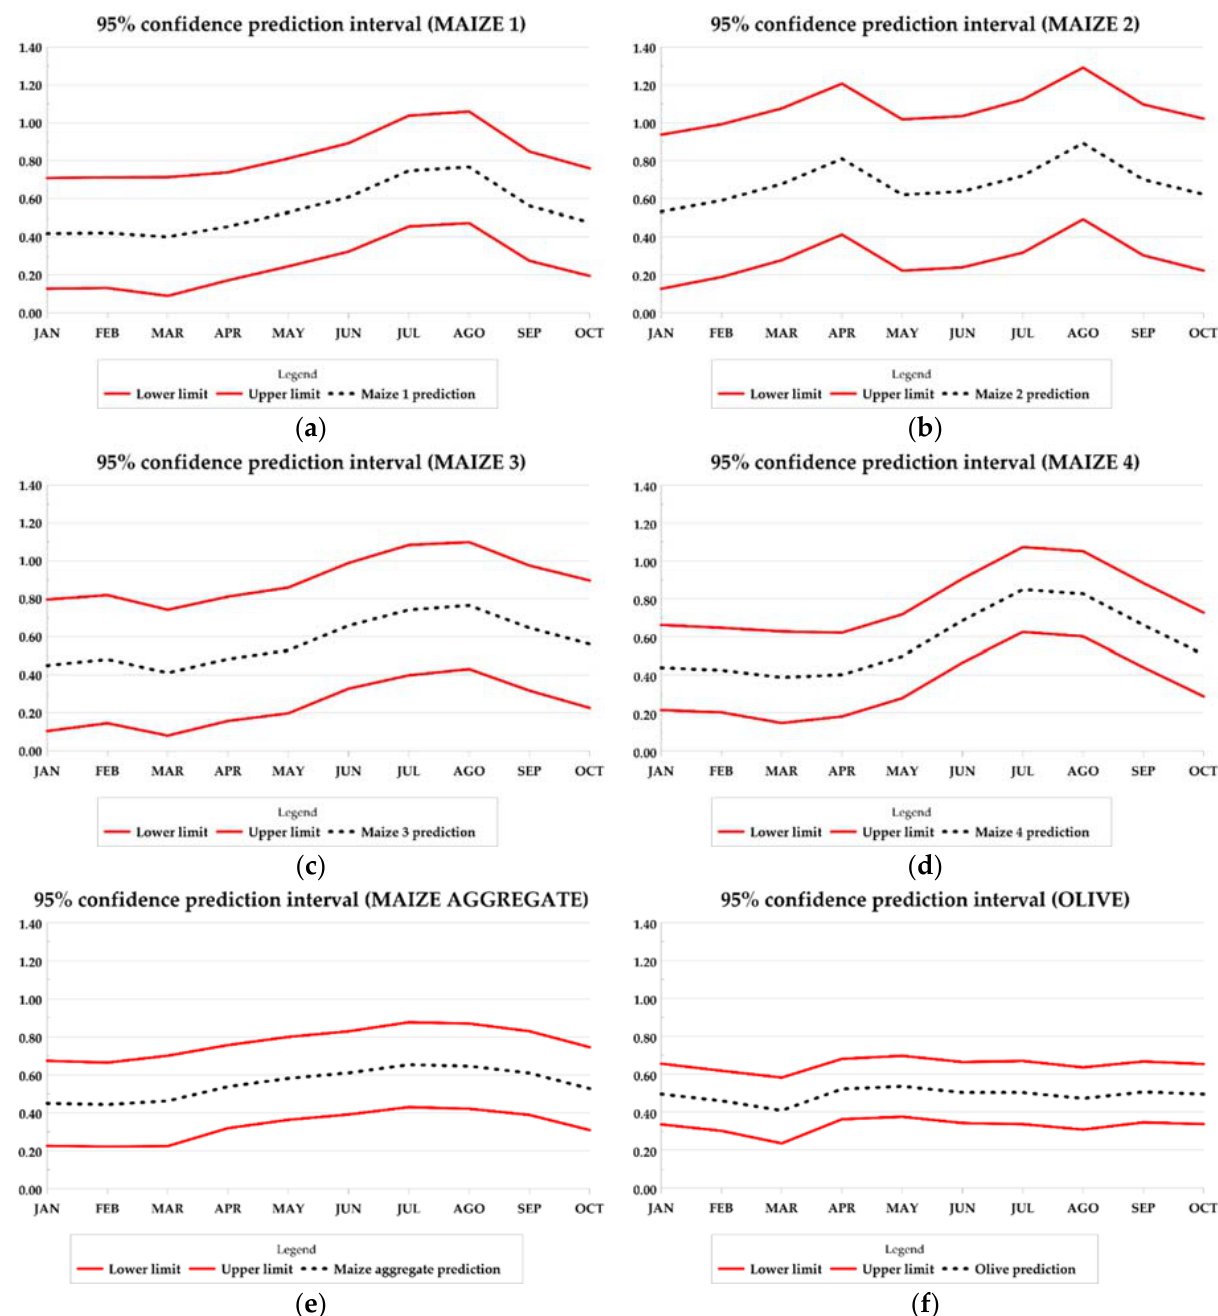
Figure 16. Subfirgures ( a – d ) presents maize crop types (1)–(4) forecast intervals with the associated α = 0.05. Subfigure ( e ) presents aggregatemMaize crop types (1)–(4) forecast intervals with the associated α = 0.05. Subfigure ( f ) presents olive crop type forecast intervals with the associated α = 0.05..